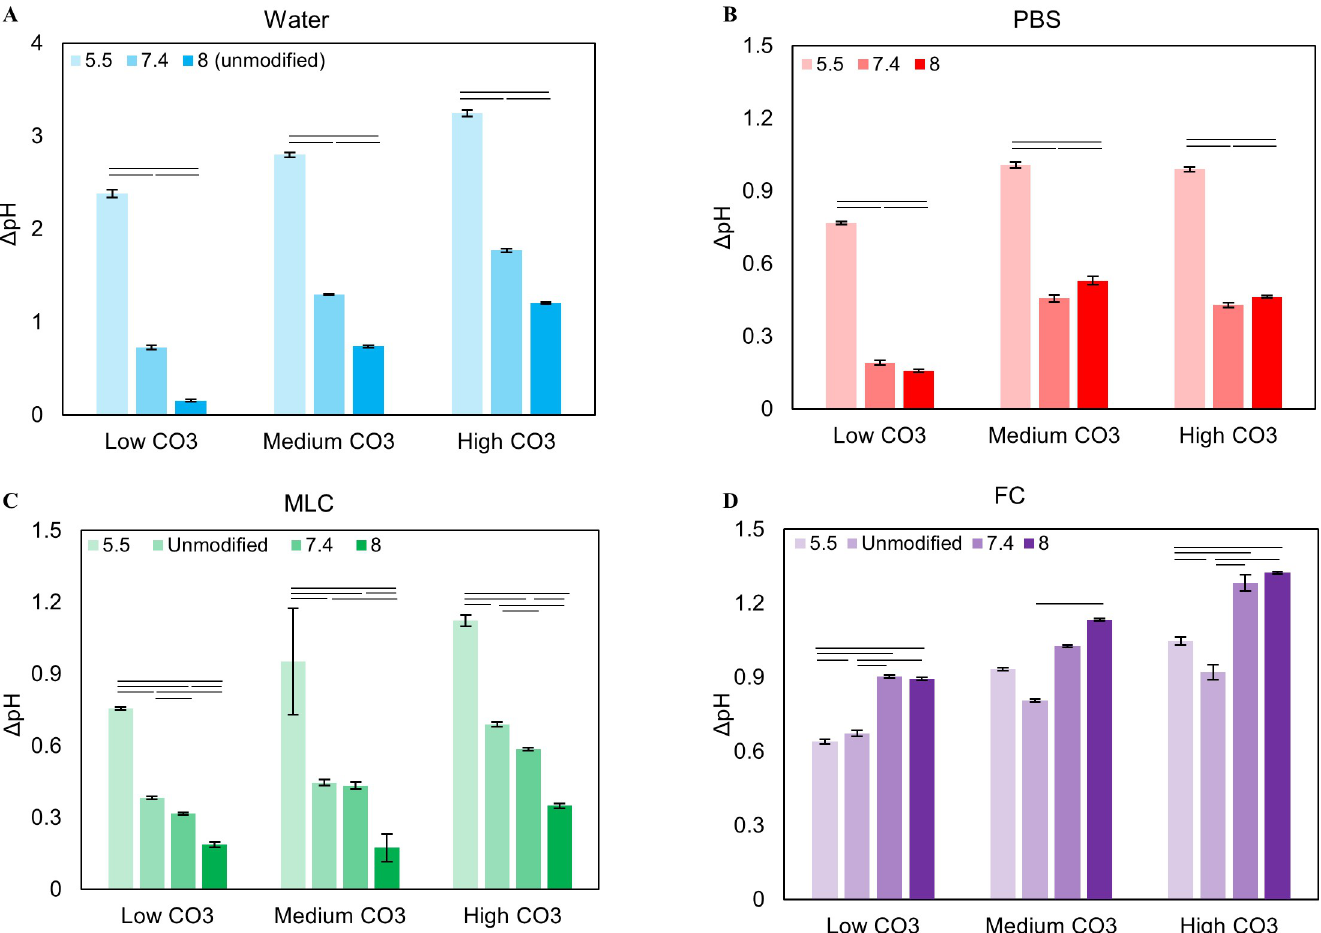
Fig 3. The change in pH ( Δ pH) of the solutions as a function of initial pH. Δ pH increased as initial pH decreased for Water, PBS, and MLC, indicating that the powder is buffering the solution more at lower pHs (A, B, C) . For FC, Δ pH increased as initial pH increased (D) .